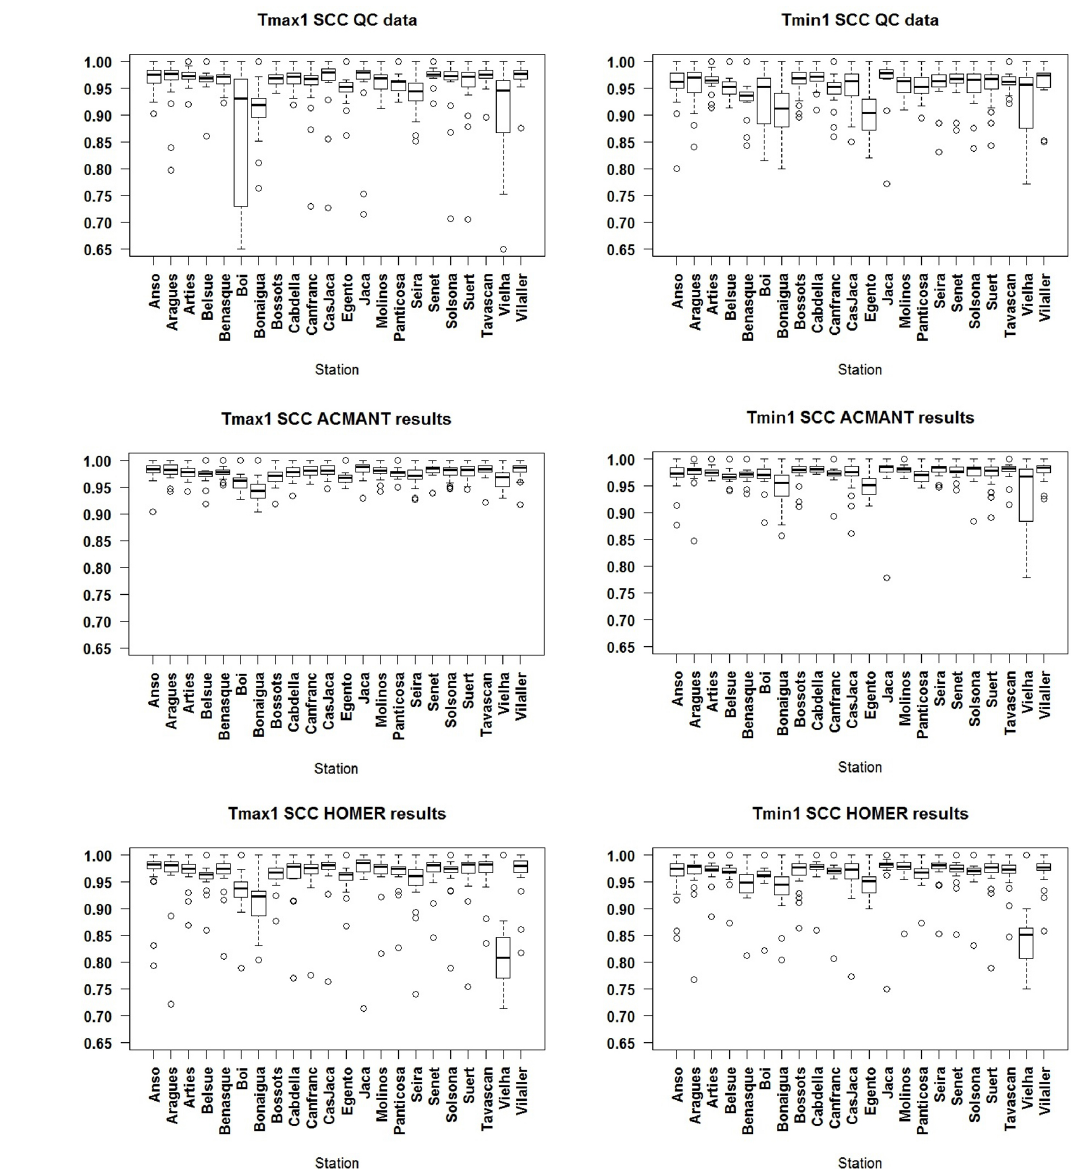
Figure 5. Boxplots of Spearman Correlation Coefficients of QC data (top panels), and ACMANT (middle panels) and HOMER (bottom panels) homogenized data for maximum (left panels) and minimum (right panels) temperature for stations in cluster